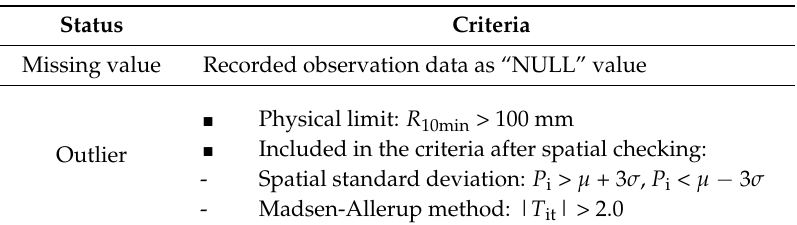
Table 1. Criteria of missing and outlier